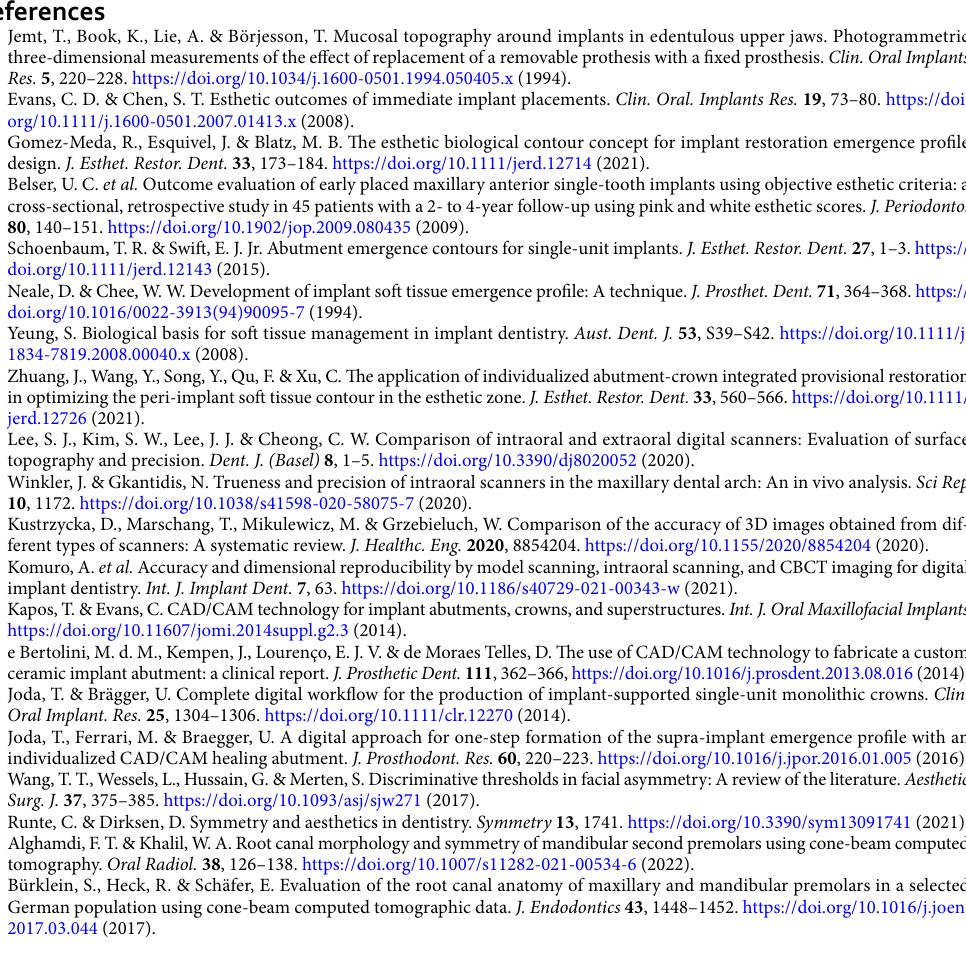
Statistics. All statistical analyses were performed using software (SPSS, Version 25.0; IBM, Armonk, NY, USA) with a significance level of 0.05. To evaluate substantial interoperator agreement on specific anatomic locations, Cohen’s kappa ( k ) coefficient was used to measure the strength of agreement between operators. One- way analysis of variance was used to determine whether there was statistical evidence that the associated HD values of true positive pairs, false negative pairs, and true negative pairs were significantly different. The ROC curves were produced to evaluate the performance of the pair comparison algorithm by calculating and plotting the true positive rate (sensitivity) against the false positive rate (1-specificity). To visualize the distribution of overlapping data points of the 3D HD results, jitter plots were created. Data availability The datasets generated during the current study are available from the corresponding author (H.-K.K.) on reasonable request.